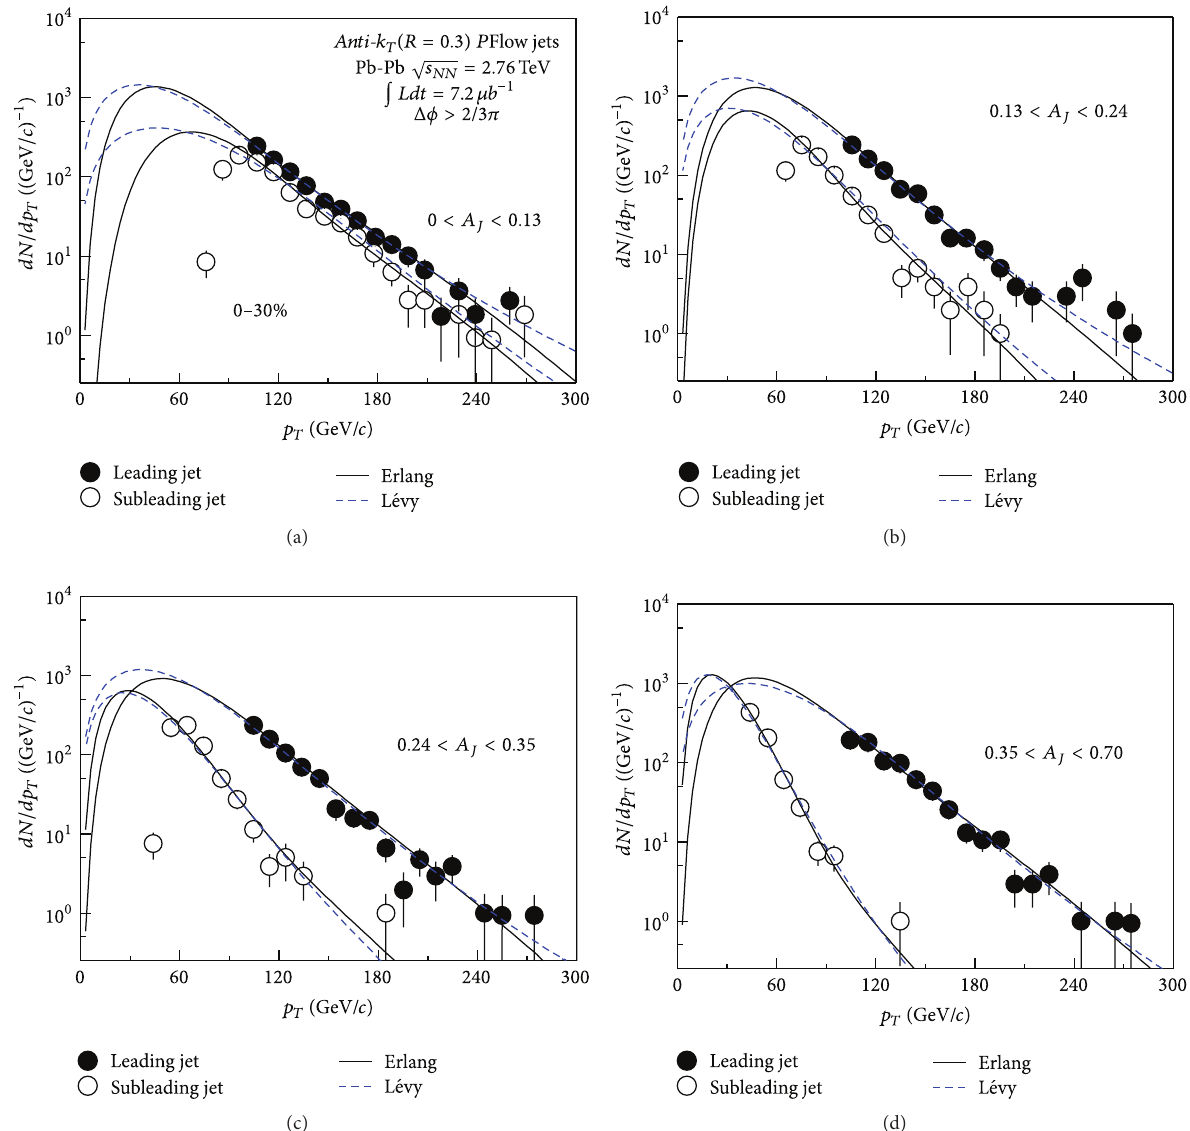
Figure 4: The same as that for Figure 2, but showing another data sample in which the dijet imbalance parameter 𝐴 𝐽 is regarded as the selected condition. (a), (b), (c), and (d) correspond to different 𝐴 𝐽